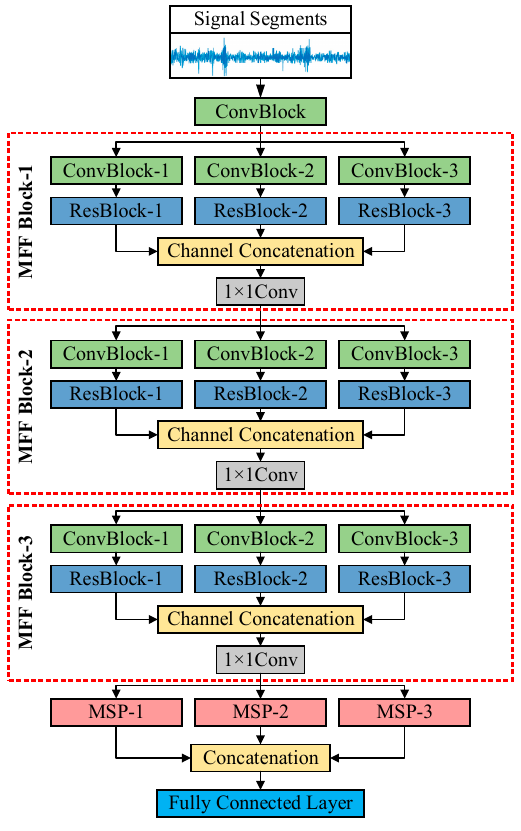
Figure 2. Structure of MFFDRN.